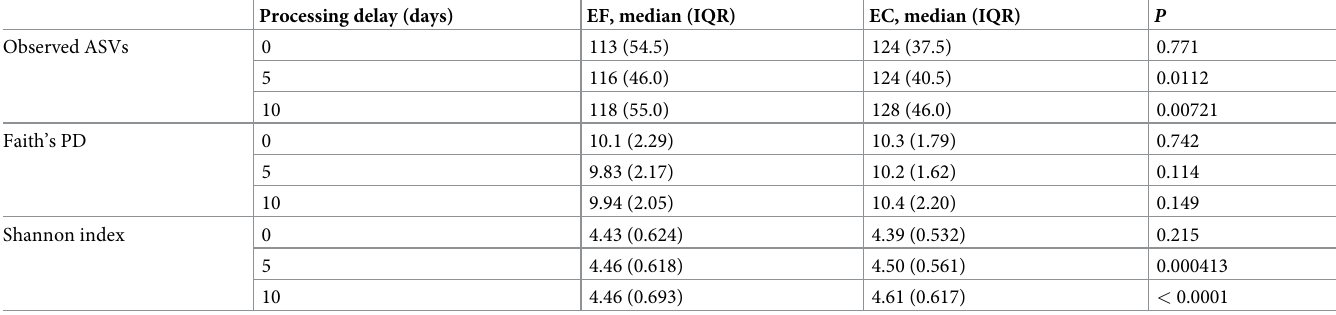
Table 1. Comparison of alpha diversity metrics between ethanol-free (EF) and ethanol-containing (EC) mouthwashes by processing time. Processing delay